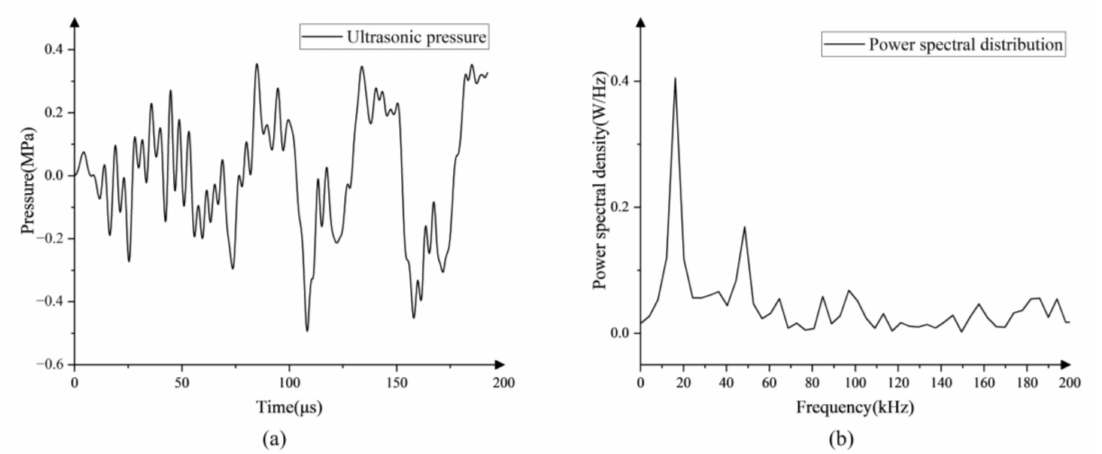
Figure 2. ( a ) Pressure-time profile measured in the liquid and ( b ) the corresponding frequency spectrum graph.